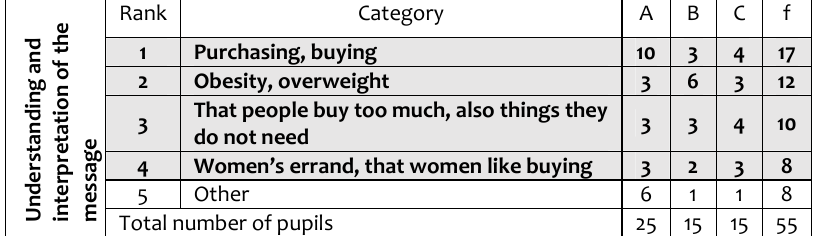
Table 18: Ranking order of answers regarding understanding and interpretation of the message of the seventh example (Duane Hanson, Supermarket Lady,